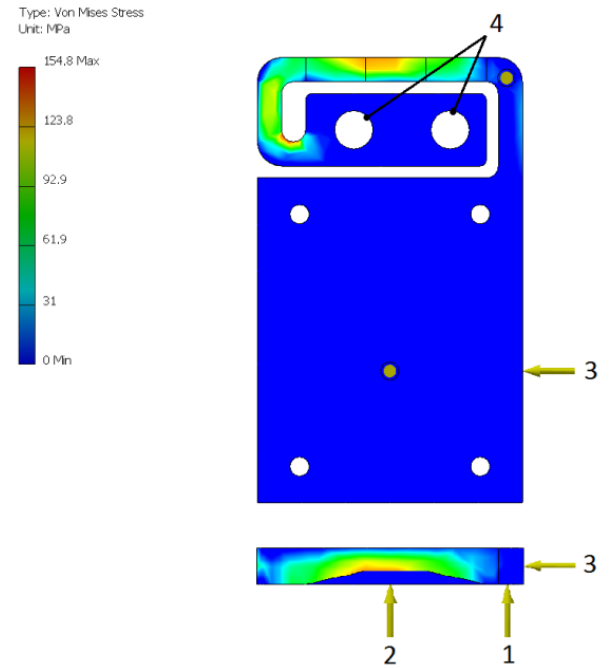
Figure 4. Mechanical stress within the aligning